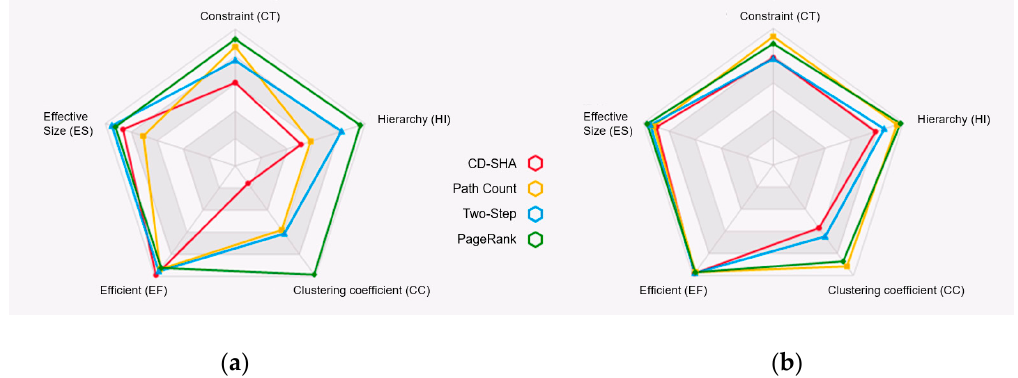
Figure 7. Average values. ( a ) Dolphin social network and ( b ) college football network.